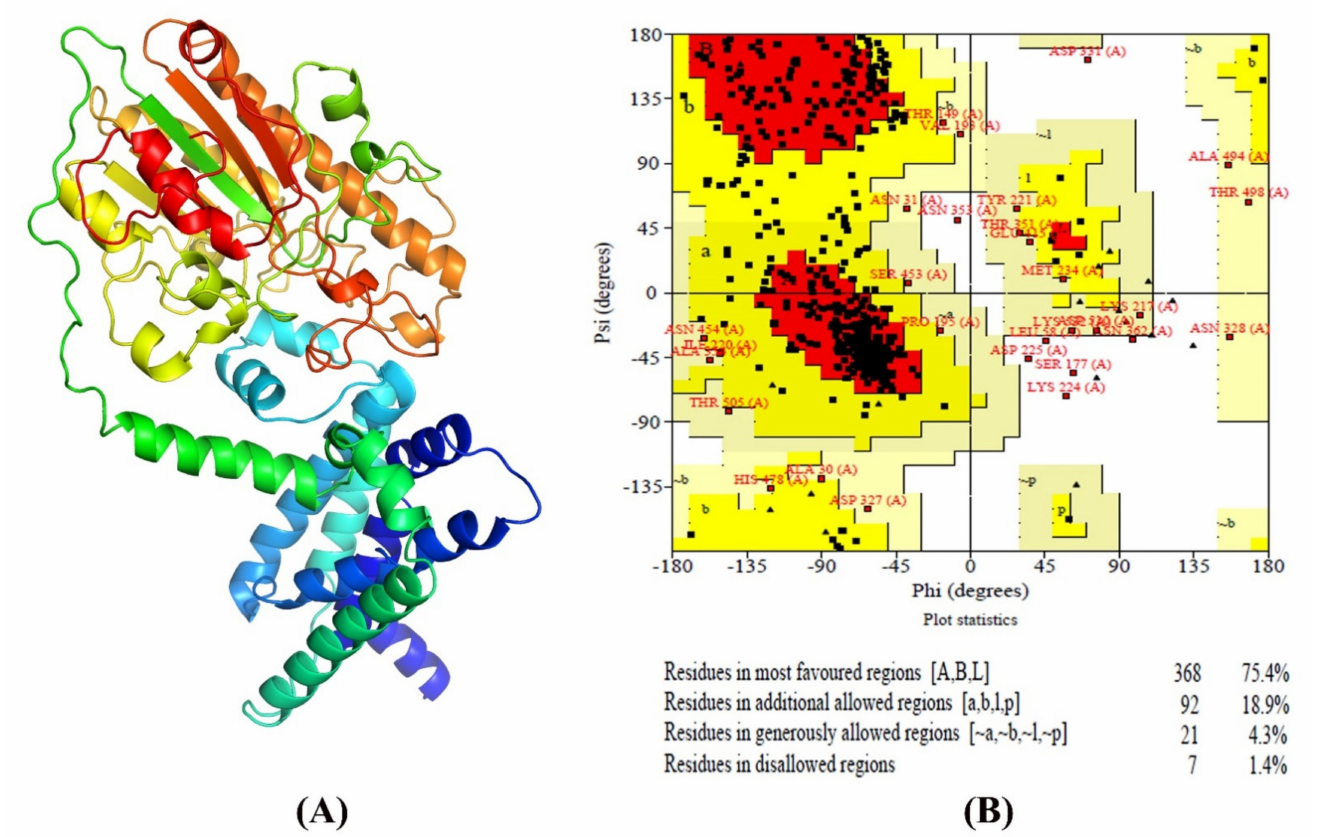
Figure 5. Validation of SAUVM MCR-1 protein modeled structures. ( A ) I-TASSER was used for three- dimensional (3D) modelling of SAUVM MCR-1 proteins, which functions by identifying structure templates from the PDB library. The C-score is a quantitative indicator of each model. SAUVM E1 model was chosen at random from these MCR-1 protein models and ( B ) analyzed, and structures were validated using Ramachandran Plot Assessment server